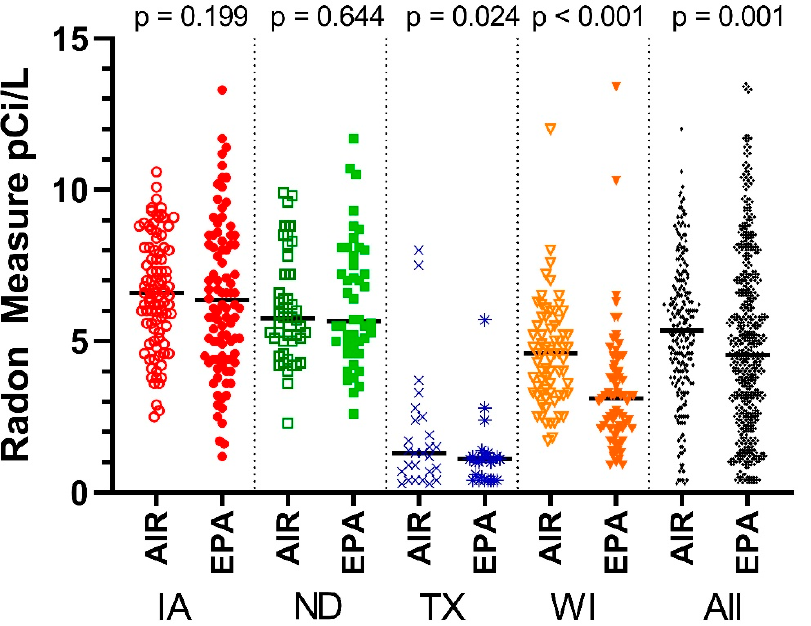
Figure 1. Pairwise comparison of average Air Chek and EPA radon measures by state. Abbreviations: AIR = Air Chek radon measures, EPA = EPA radon measures.